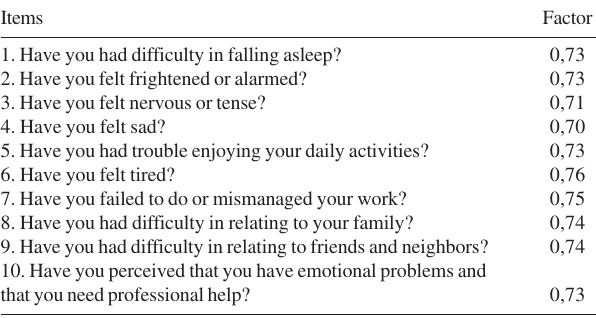
Table 2 - Factorial structure of the Portuguese version of the Personal Health Scale in a combined sample of patients and of health